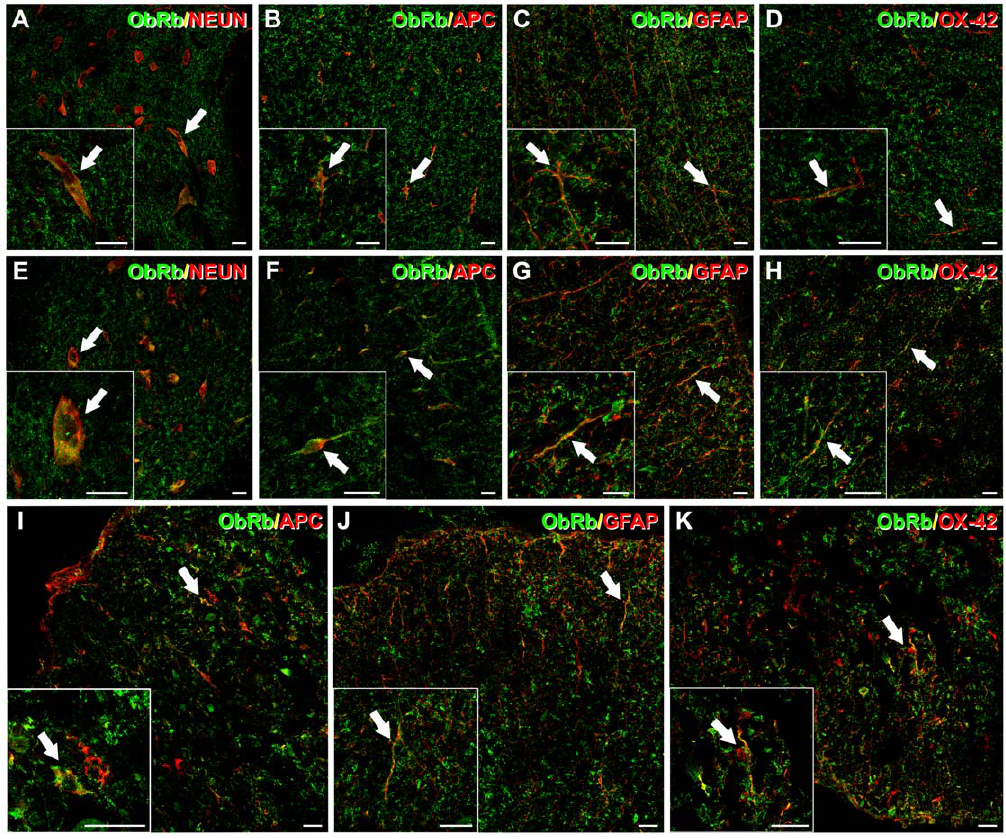
Figure 2. Immunohistochemical analysis of ObRb expression after SCI. Dual immunohistochemistry was performed in uninjured spinal cord sections, and 24 h post-SCI on spinal cord sections from vehicle-treated and leptin-treated animals. ObRb immunolabelling was observed in uninjured spinal cord sections (A to D) and in both rostral and caudal unaffected areas (E to H) and at the lesion epicentre (I to K). Cells expressing ObRb were identified as NeuN + neurons (A and E), APC + oligodendrocytes (B, F and I), GFAP + astrocytes (C, G and J) and OX-42 + microglia/ macrophages (D, H and K). Scale Bars=20 m m.